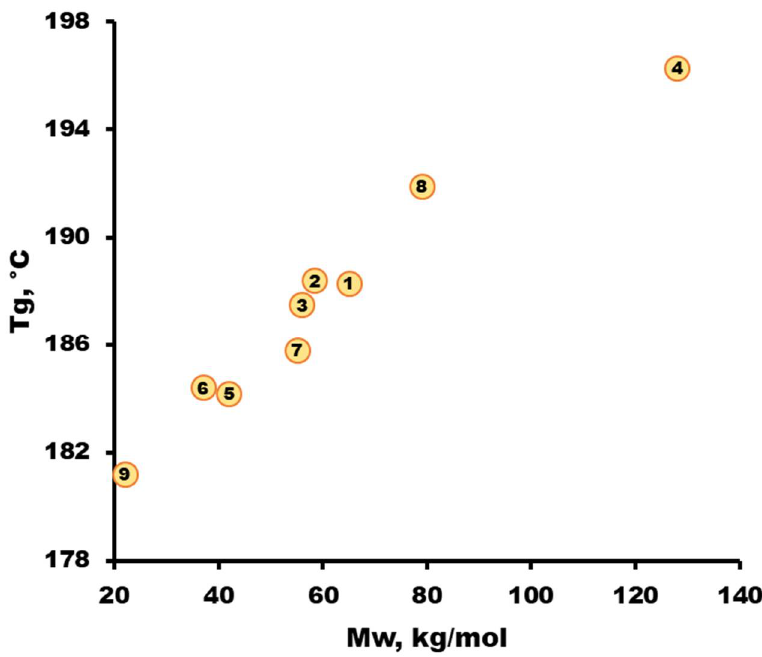
Figure 3. Dependence of the glass transition temperature determined by DSC on the molecular weight of the synthesized PSF. The sample numbers are the same as those in Table 3.